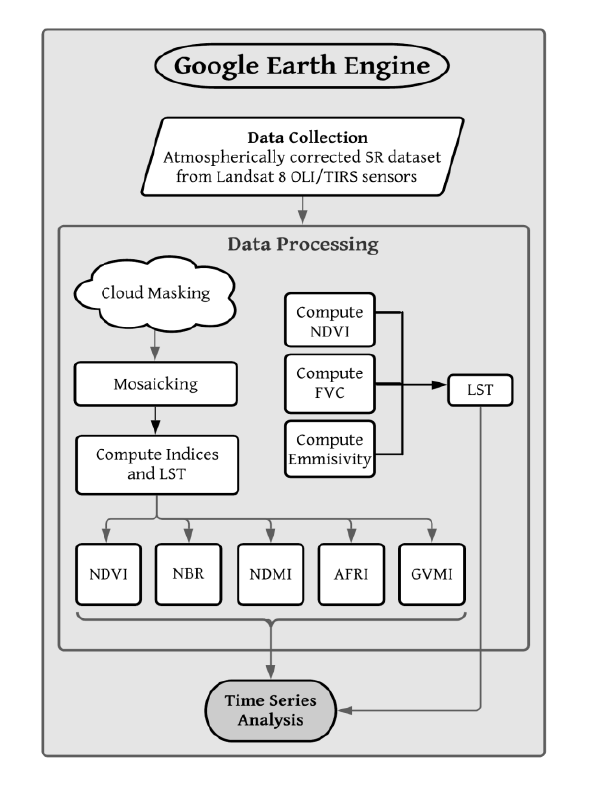
Figure 2: Methodology used for time series analysis of Indices calculated for the Mizoram region